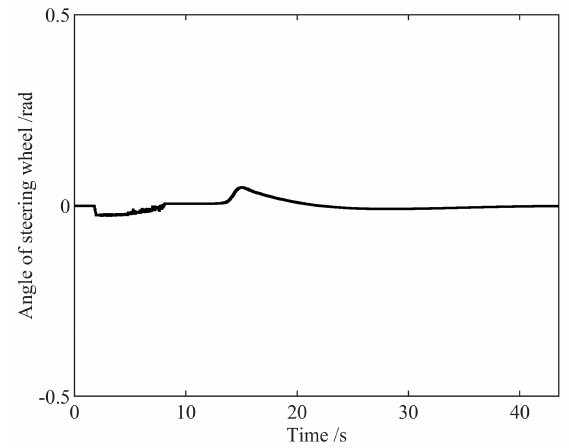
Figure 26. The angle of steering wheels in the third group of simulations.